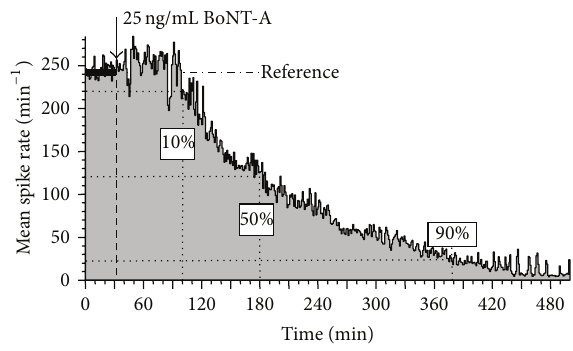
Figure 1: Average network spike production per minute as a func- tion of time. All activity changes were determined as percent activity decreases relative to the native activity (Reference).